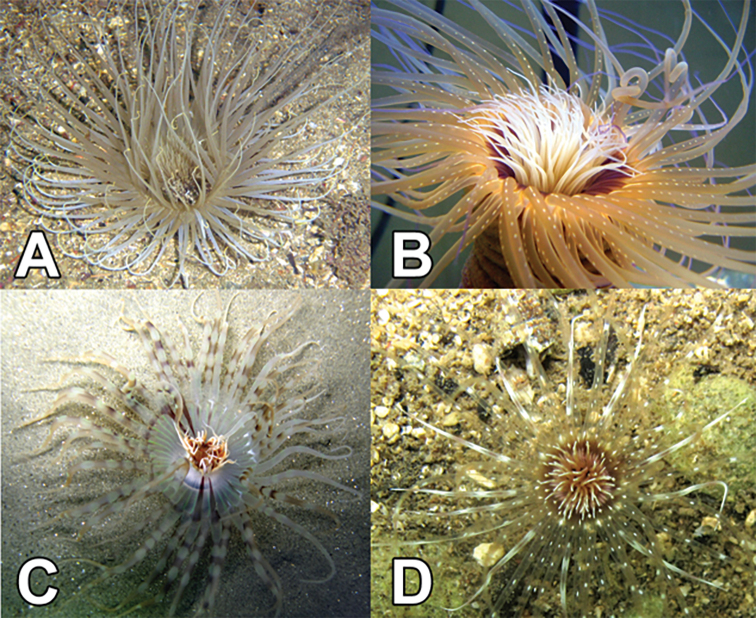
Examples of Ceriantharia: ACerianthidae, Ceriantheomorphe
brasiliensisBPachycerianthus
schlenzaeCArachnactidae, Isarachnanthus
nocturnusDBotrucnidiferidae, Botruanthus
mexicanus (Photograph Ricardo Gonzalez-Muñoz).